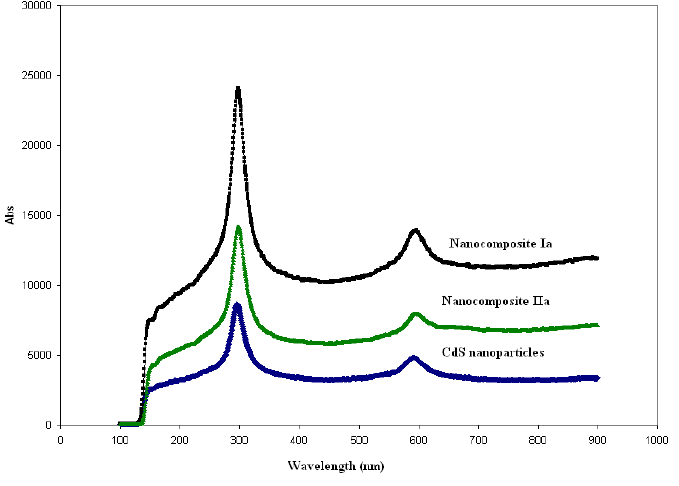
Figure 5. Raman spectra for pure CdS and CdS nanocomposites for Ia and IIa at the mass composition (1.0:1.0,